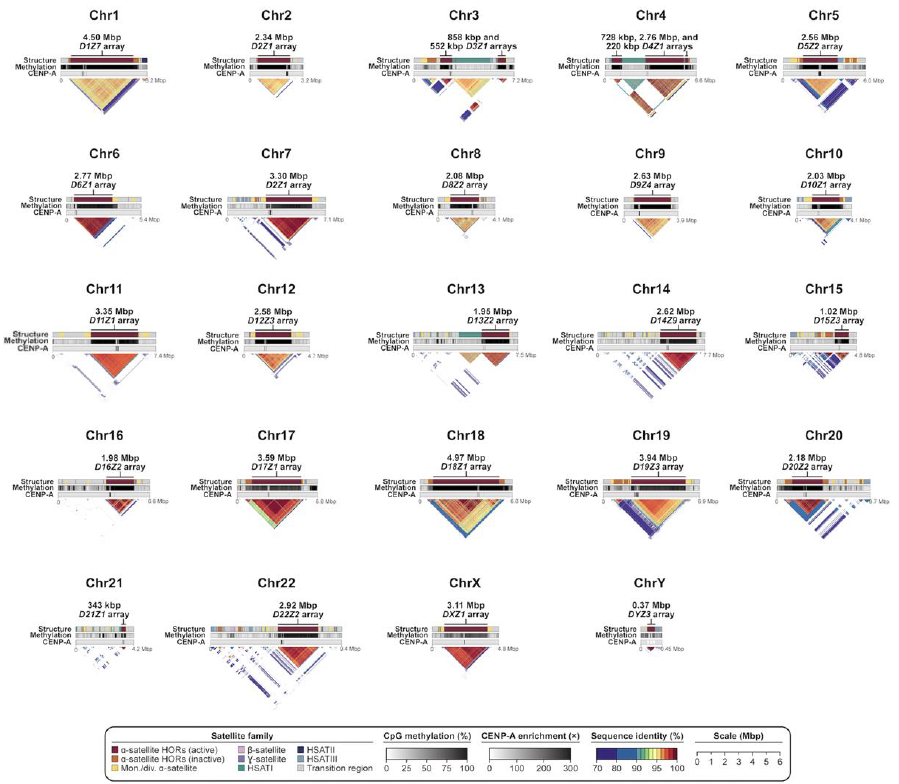
Figure 2. Sequence composition, DNA methylation pattern, and CENP-A chromatin organization of each centromere in the T2T-CHM13 genome. Tracks showing the sequence composition, frequency of methylated CpG dinucleotides, and fold-enrichment of CENP-A ChIP-seq reads over bulk nucleosomal reads (or in the case of chromosome Y, the number of CENP-A CUT and RUN reads) for each centromere in the T2T-CHM13 v2.0 genome. Triangular StainedGlass [56] plots indicate the pairwise sequence identity between 5 kbp segments along each centromeric region and are colored by sequence identity. Warmer colors indicate higher sequence identity, and colder colors indicate lower sequence identity (as indicated in the legend).